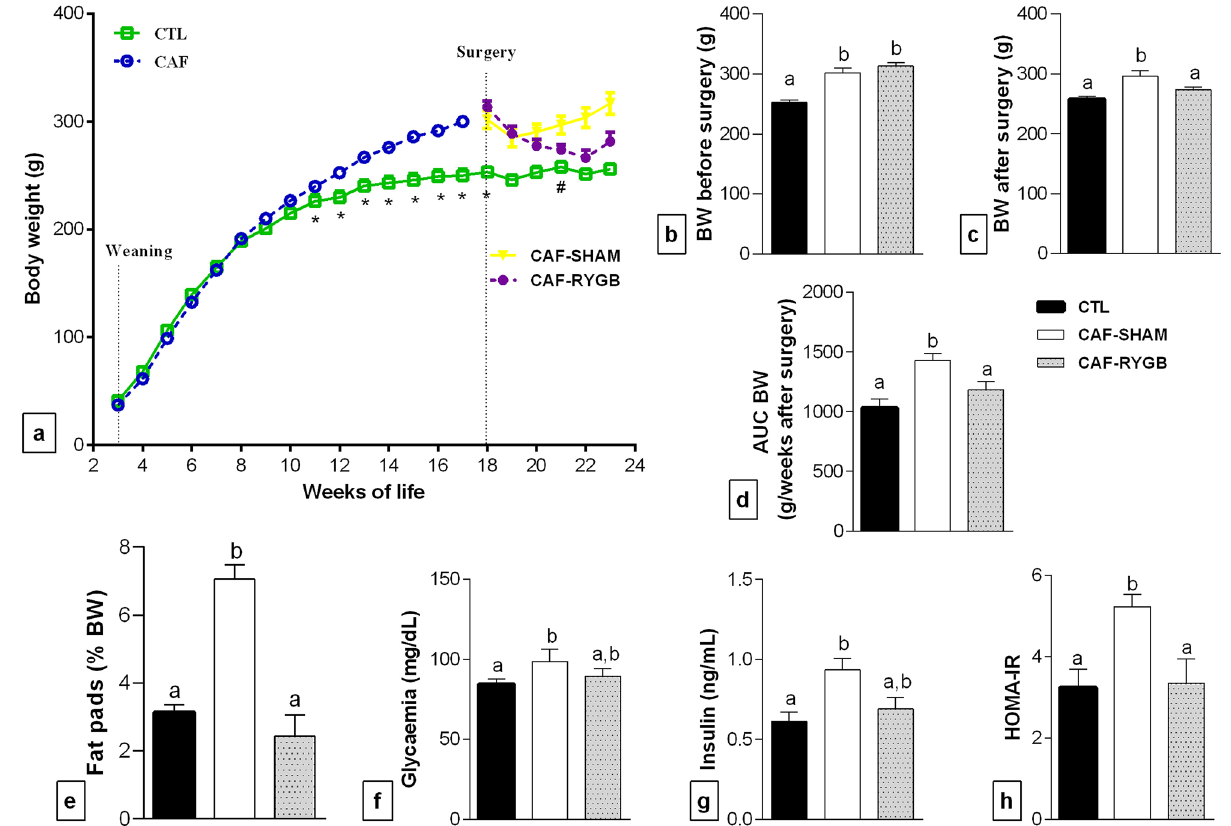
Figure 1. Biometric and serum biochemical parameters in maternal groups submitted, or not, to RYGB. CTL, female rats fed standard diet (n = 5–11 animals); CAF-SHAM, female rats fed on CAF diet and submitted to sham operation (n = 5–12 animals); CAF-RYGB, female rats fed on CAF diet and submitted to RYGB (n = 5–22 animals). Maternal biometric and biochemical parameters were analysed: Evolution of body weight with the CAF diet, before and after RYGB or SHAM operation ( a ), body weight before surgery ( b ), body weight after surgery ( c ), body weight area under curve ( d ), Fat pads ( e ), glycaemia ( f ), insulin ( g ), HOMA-IR ( h ). Different letters indicate statistical differences by one-way ANOVA and Bonferroni post-test ( p < 0.05). The data are mean ± SEM. * p < 0.05 (Student’s t test). # p < 0.05 (CAF-RYGB vs CAF-SHAM). Parameters CTL